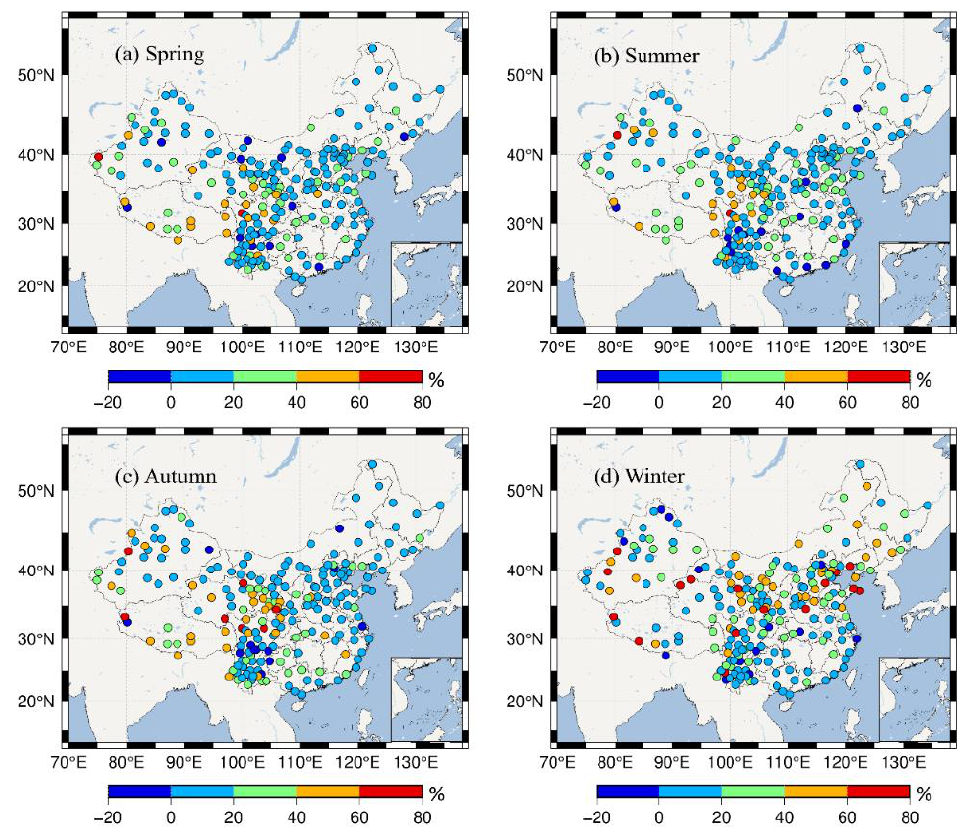
Figure 8. Distribution of the improvement rates of all verification stations in different seasons at time scales.